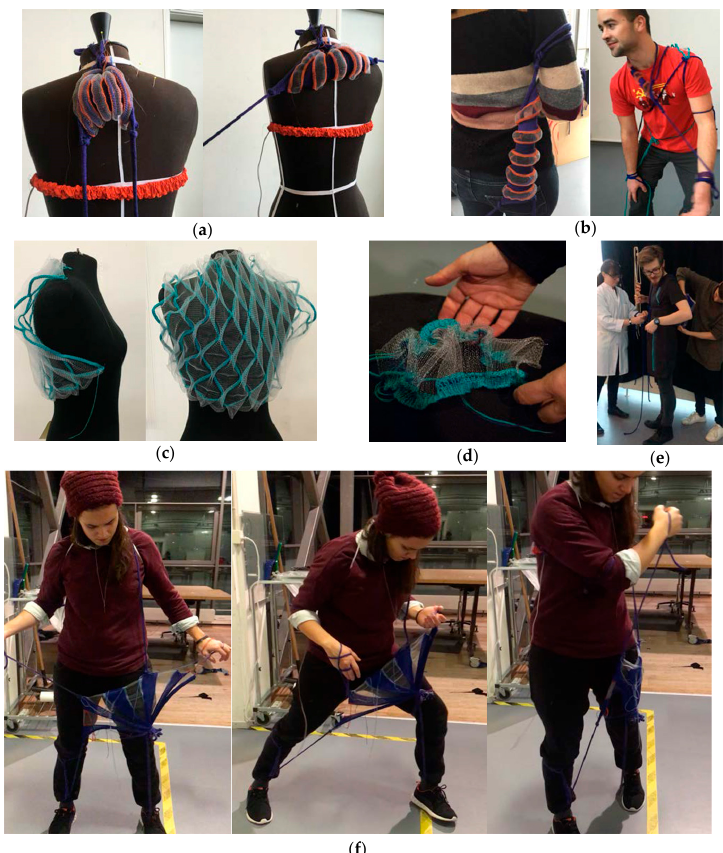
Figure 5. Loom 2 probe-set (2): Creatures + Straps. ( a ) + ( c ) studio testing; ( b ) + ( d ) participant play in the loom; ( e ) dressing a participant; ( f ) studio testing.